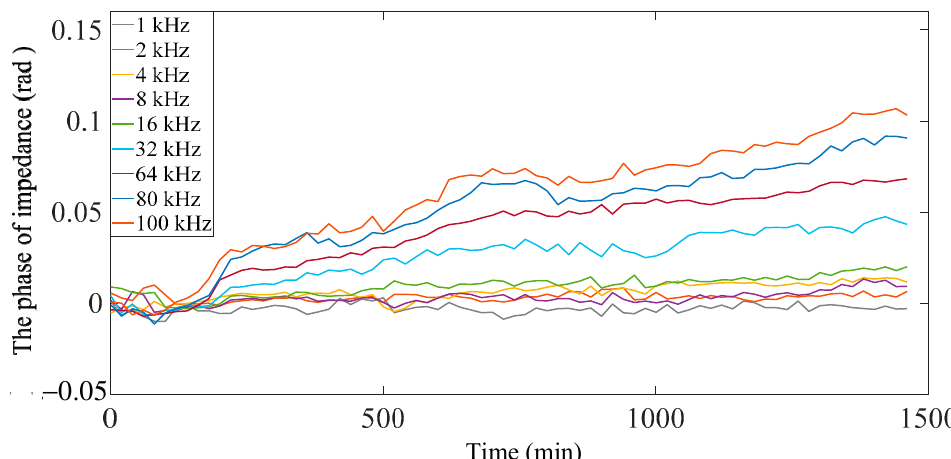
Figure 11. The phase curves of impedance by the nanocrystalline T37 current sensor.